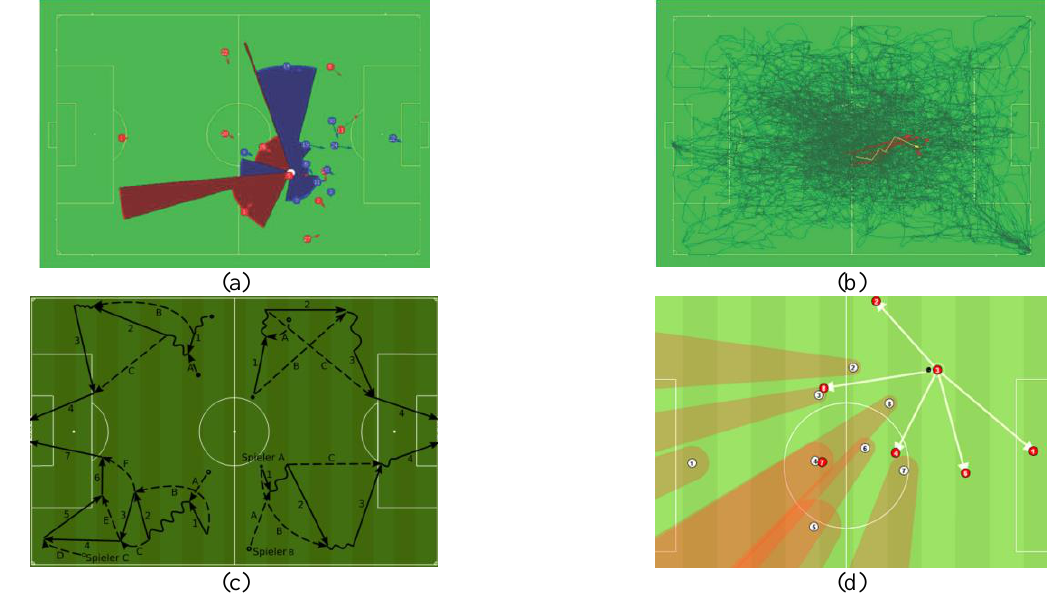
Figure 1. (a) Passable regions visualized with red (to players in the same team as the ball holder) and blue (to players in the opposite team); (b) Movement of a player, and a cluster of frequent movements highlighted in red (Gudmundsson and Wolle 2010). (c) different patterns of motion and interaction (Grunz et al. 2009). (d) Passing possibilities of a ball possessing player (the black dot is the ball; possible passes are marked via white